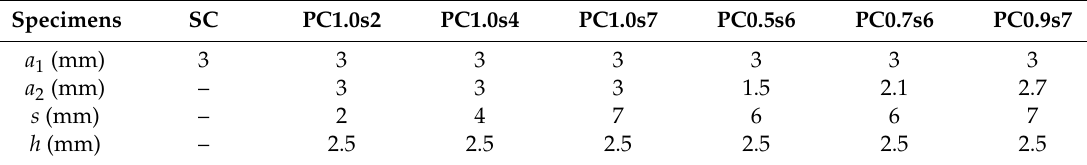
Figure 1. Specimen geometry: ( a ) specimen with single crack, ( b ) specimen with double parallel cracks, and ( c ) dimensions of the notch configuration (initial crack). Table 3. Initial sizes and positions of the cracks in seven groups of